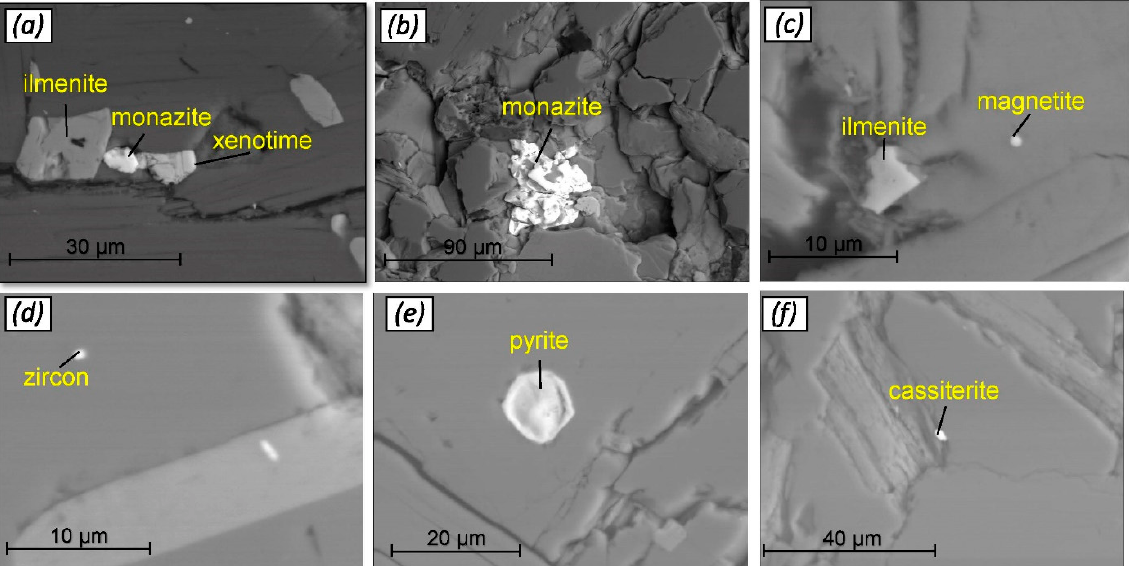
Figure 4. Micrometer accessory minerals in hornfels from the Tochka area (vein 2, sample TO-11, TO-5). ( a ) Nests of ilmenite, monazite, and xenotime; ( b ) a nest of monazite; ( c ) ilmenite and magnetite; ( d ) sub-micrometer zircon in hornfels and tourmaline; ( e ) oval pyrite; ( f ) cassiterite in a crack.